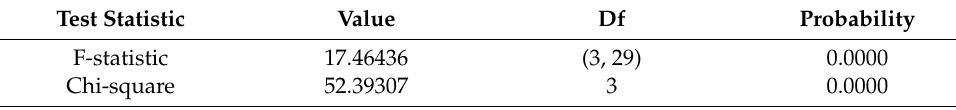
Table 7. Wald test for causality impact of services on GDP.